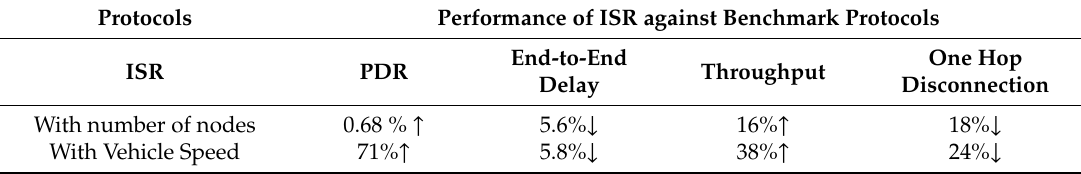
Table 5. Performance of ISR against competitive protocols with increasing ↑ or decreasing ↓ trend.